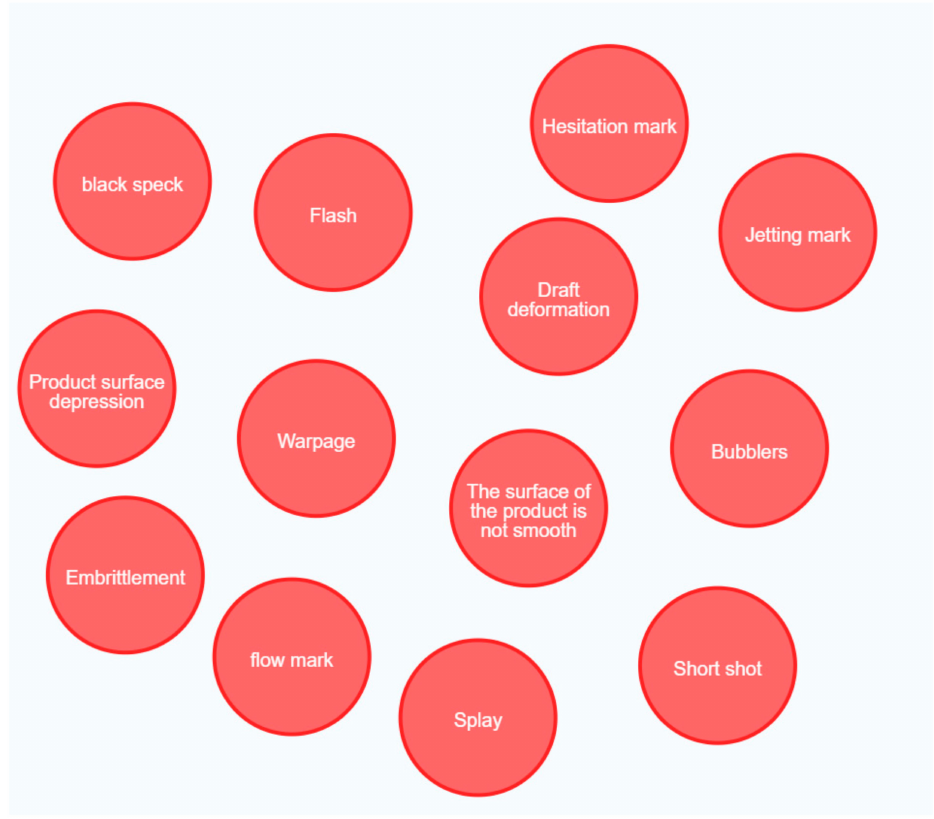
Figure 1. Problem